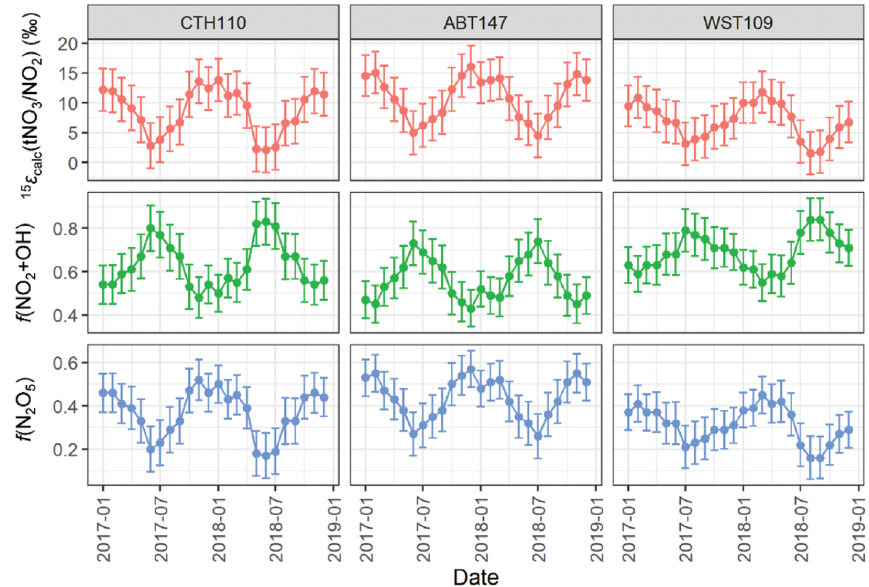
Figure 8. The calculated nitrogen enrichment factor associated with nitrate formation 15 ε (tNO 3 / NO 2 ) and the estimated relative fraction of total atmosphere nitrate (tNO 3 ) formation via the N 2 O 5 hydrolysis (Reaction R1) and NO 2 + OH (Reaction R2) pathways at the considered CASTNET sites. The error bars represent propagated